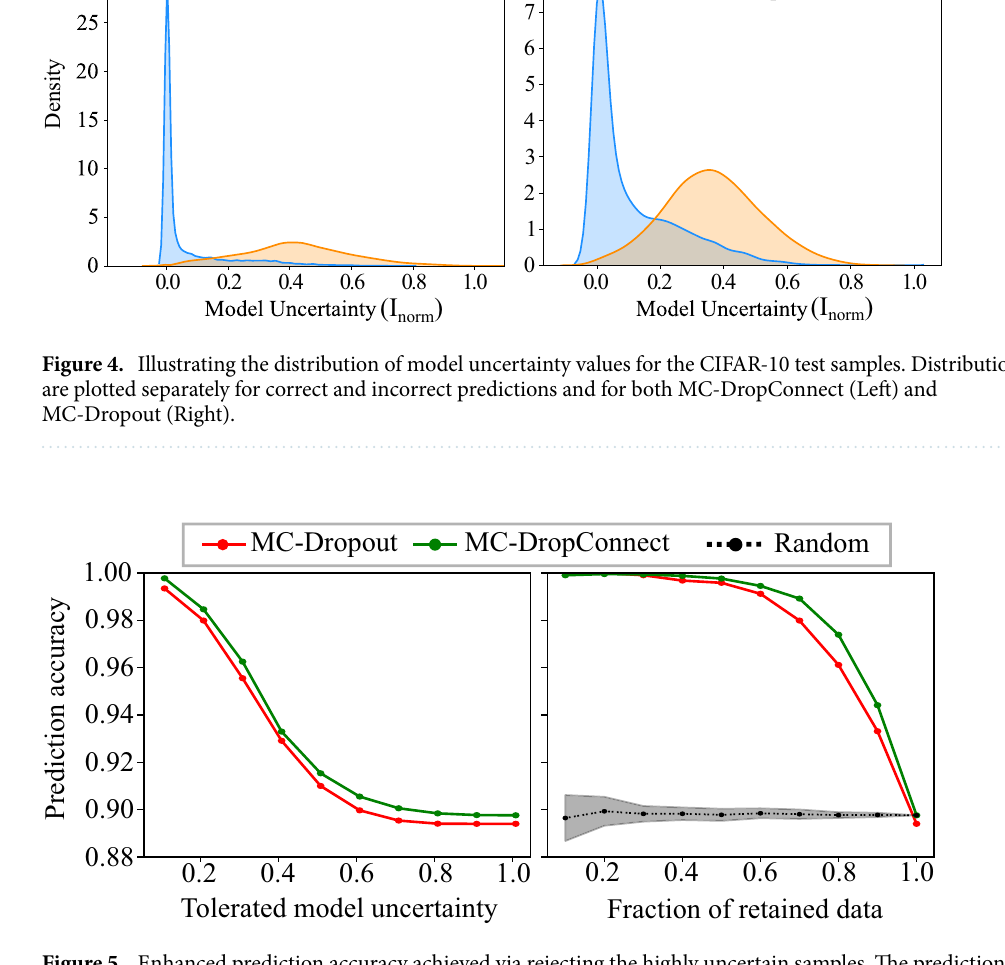
Figure 5. Enhanced prediction accuracy achieved via rejecting the highly uncertain samples. The prediction accuracy is computed over the test samples of the CIFAR-10 dataset and depicted as a function of the tolerated amount of model uncertainty (Left), and retained data size. The black curve in the right panel illustrates the effect of randomly rejecting the same number of samples. It is plotted as mean (±std) over 20 samplings. This shows that uncertainty is an effective measure of prediction